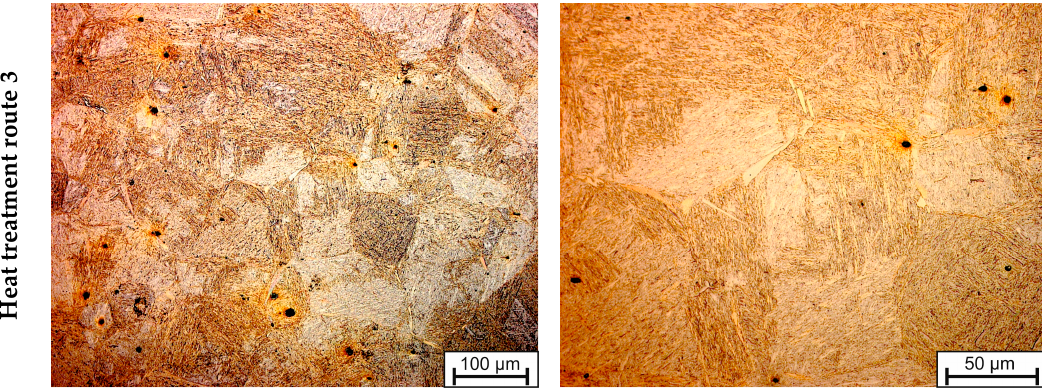
Figure 9. Micro-sections analyzed by optical microscopy to determine the former austenite grain size. While the samples exhibit a fully martensitic microstructure after quenching, the former austenite grain boundaries can clearly be observed after etching.